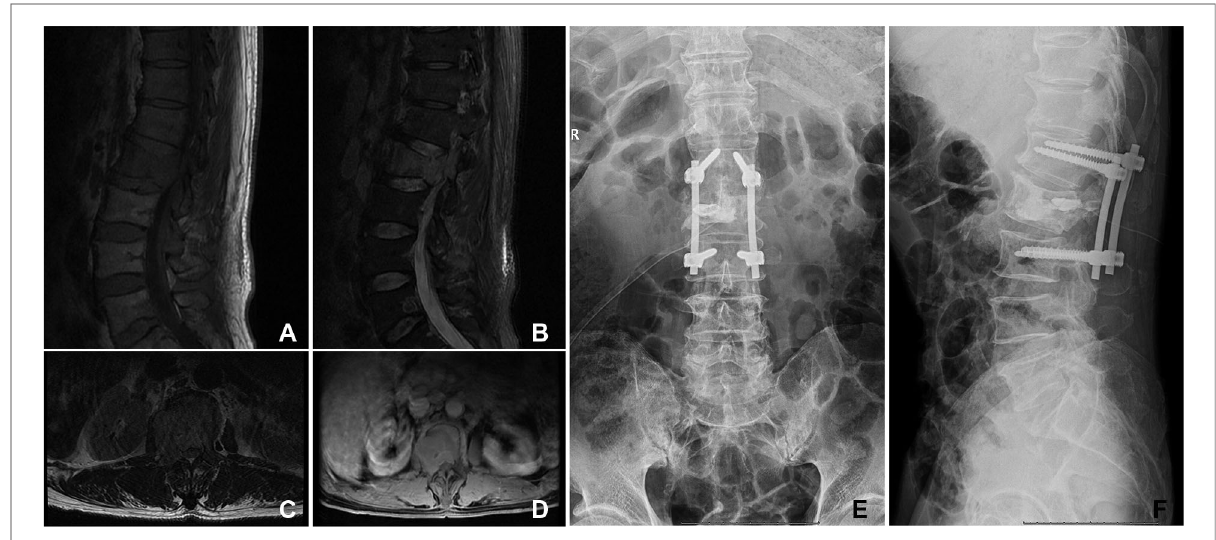
FIGURE 1 A 66-year-old woman suffered from HCC with multiple metastases of the spine and pelvis. The primary lesion of the liver was not resected. The symptoms were located in the lumbar 2 vertebra. She underwent orthopedic therapeutic surgery. ( A – D ) The L2 vertebral metastases in MRI. ( E,F ) The patient received intralesional resection with internal fi xation and PKP. PKP, percutaneous